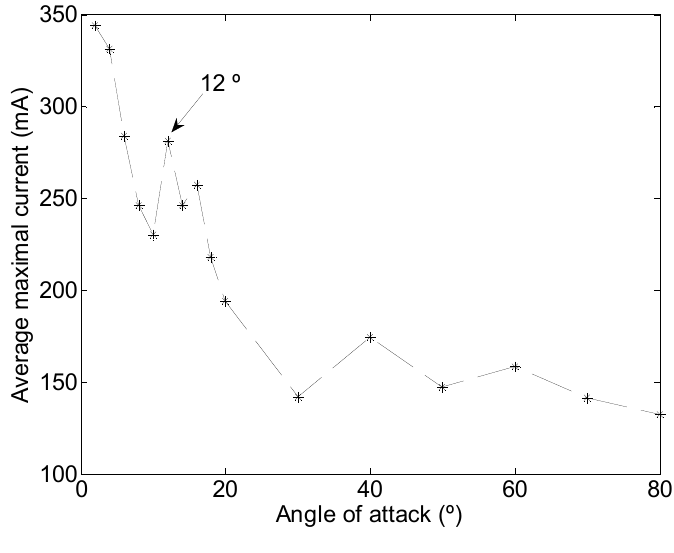
Figure 11. Average maximum current relative to the angle of